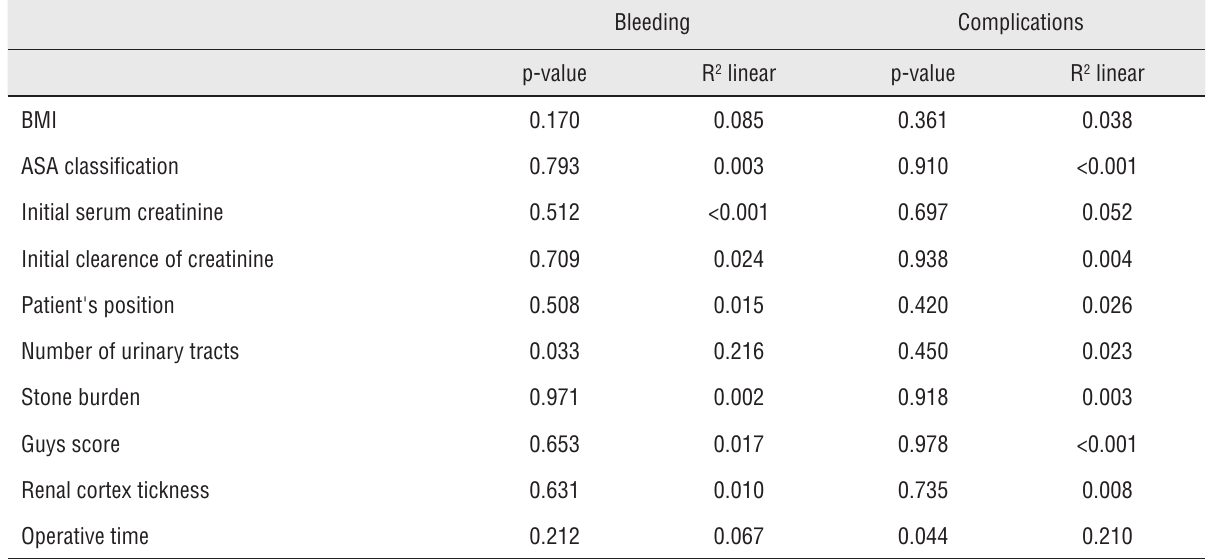
Table 3 - Univariate analysis – Sperman